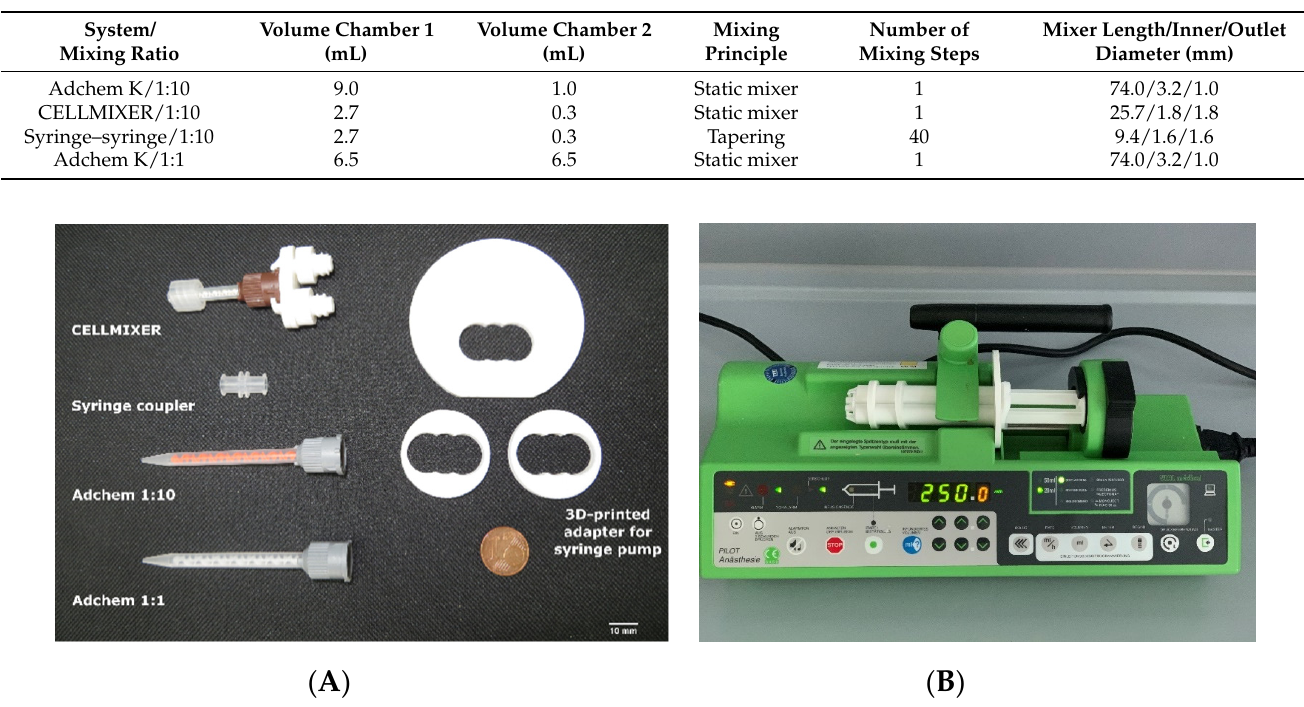
Figure 1. The mixing devices used in this study. ( A ) Appearance of the mixers (CELLMIXER, Syringe coupler, Adchem 1:10 and 1:1) without the cartridges and the custom designed adapter for the 1:1 Adchem K system; ( B ) custom designed adapter to hold the 1:1 Adchem K cartridge in shape while using the syringe pump without mixer. Scale bar = 10 mm.